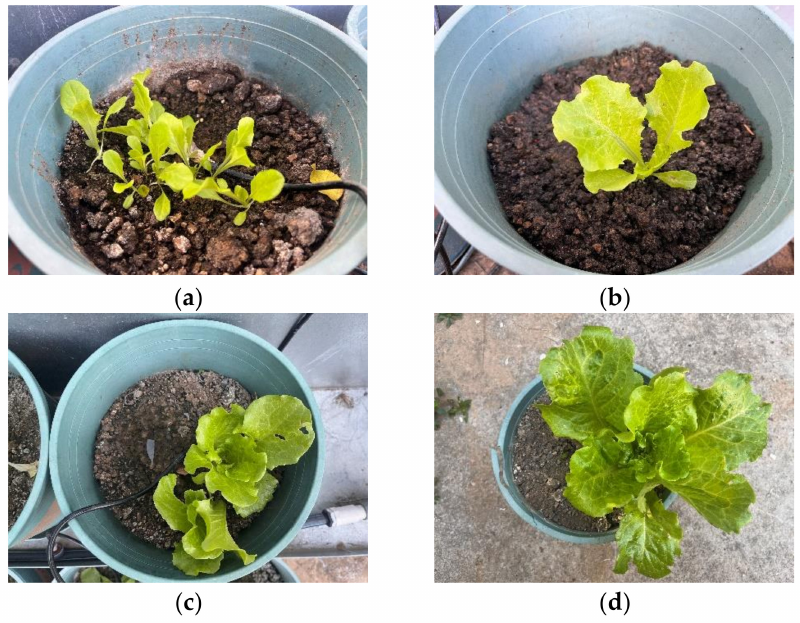
Figure 1. Each growth period of lettuce. ( a ) Germination period. ( b ) Five Leaves One Heart Period. ( c ) Seedling period. ( d ) Rosary period.